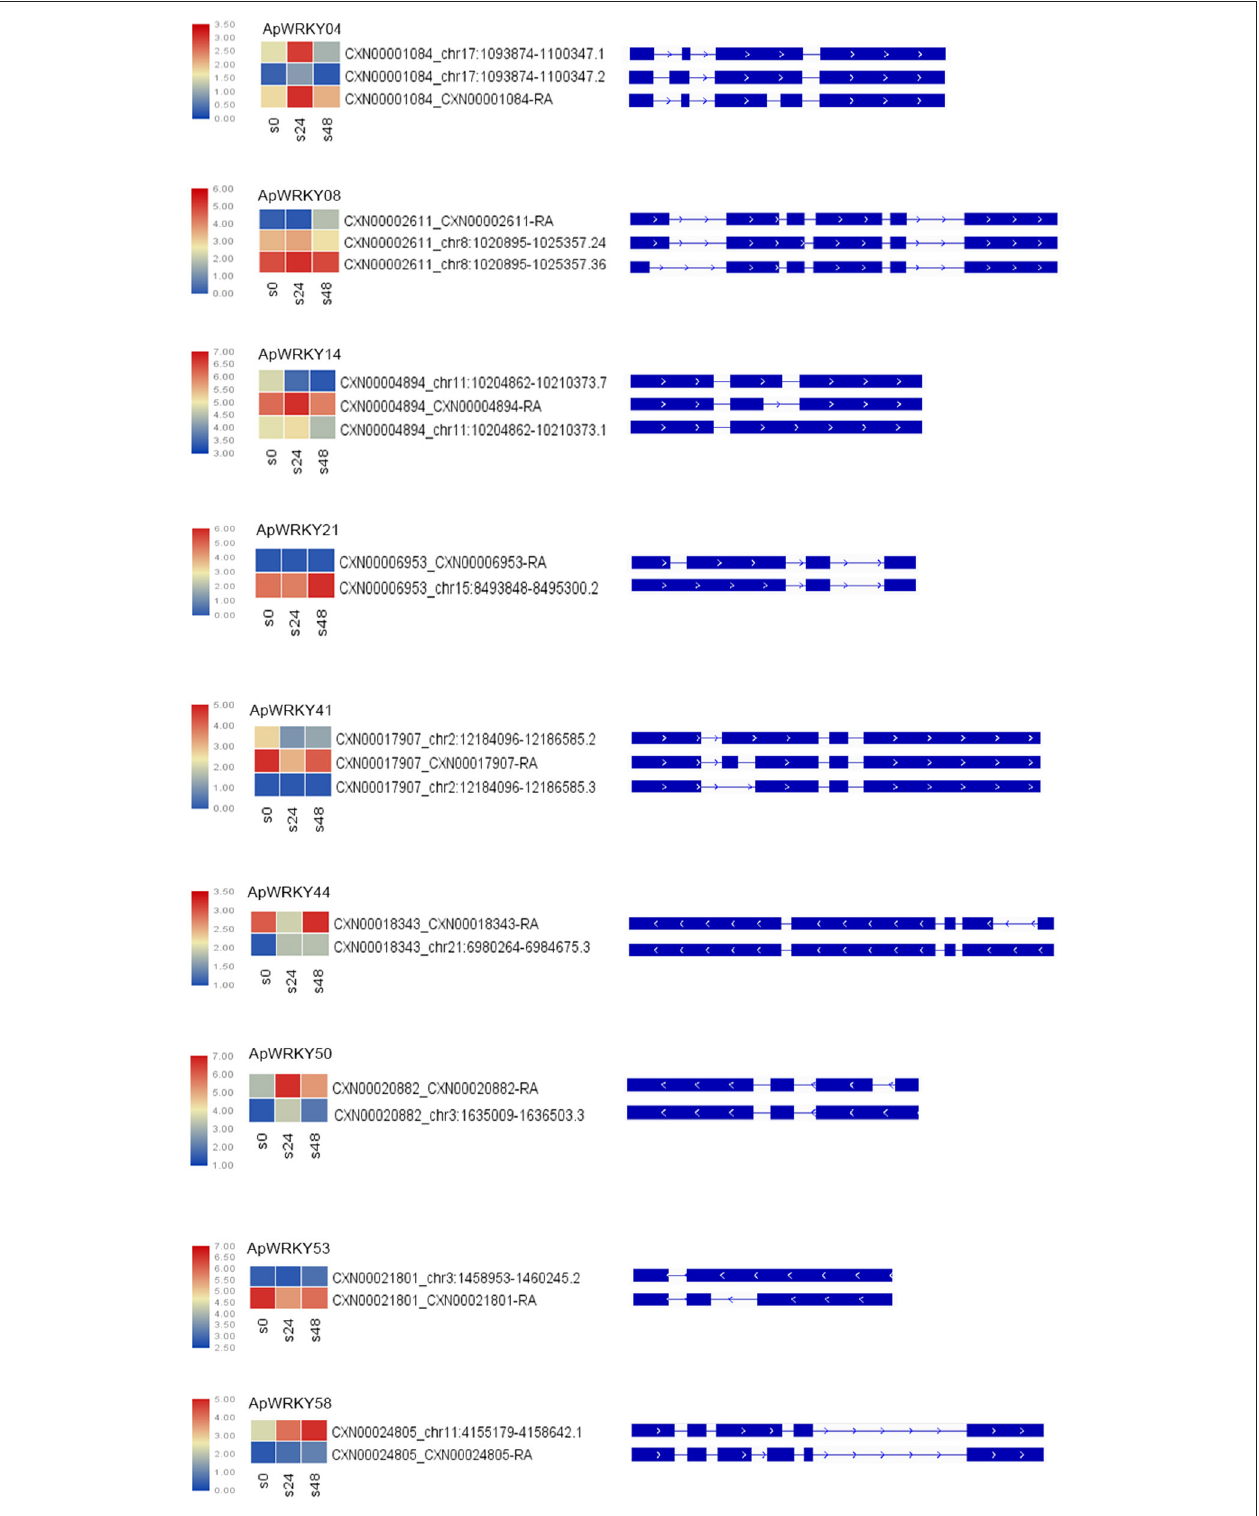
FIGURE 6 | Alternative splicing isoforms of nine ApWRKY genes. Heatmap of the isoforms showed changes in the gene expression of various isoforms under MeJA stress.